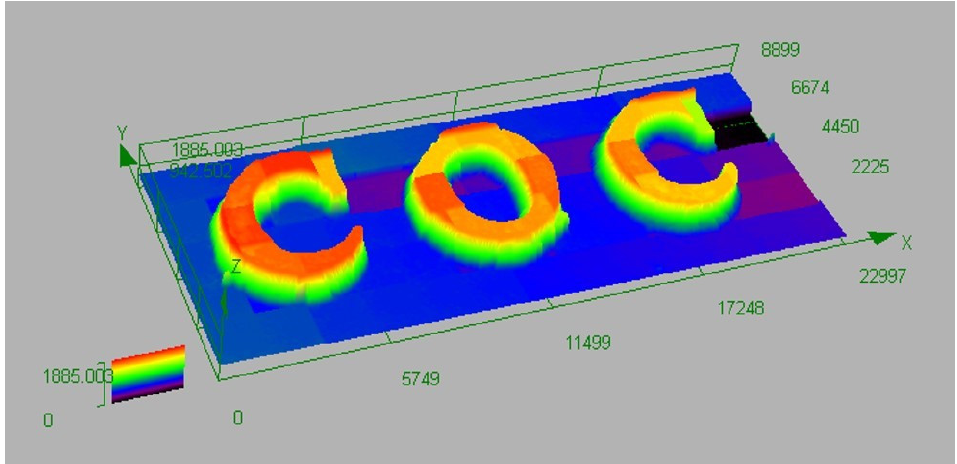
Figure 9. The pattern “COC” was observed by numerical optical microscopy.